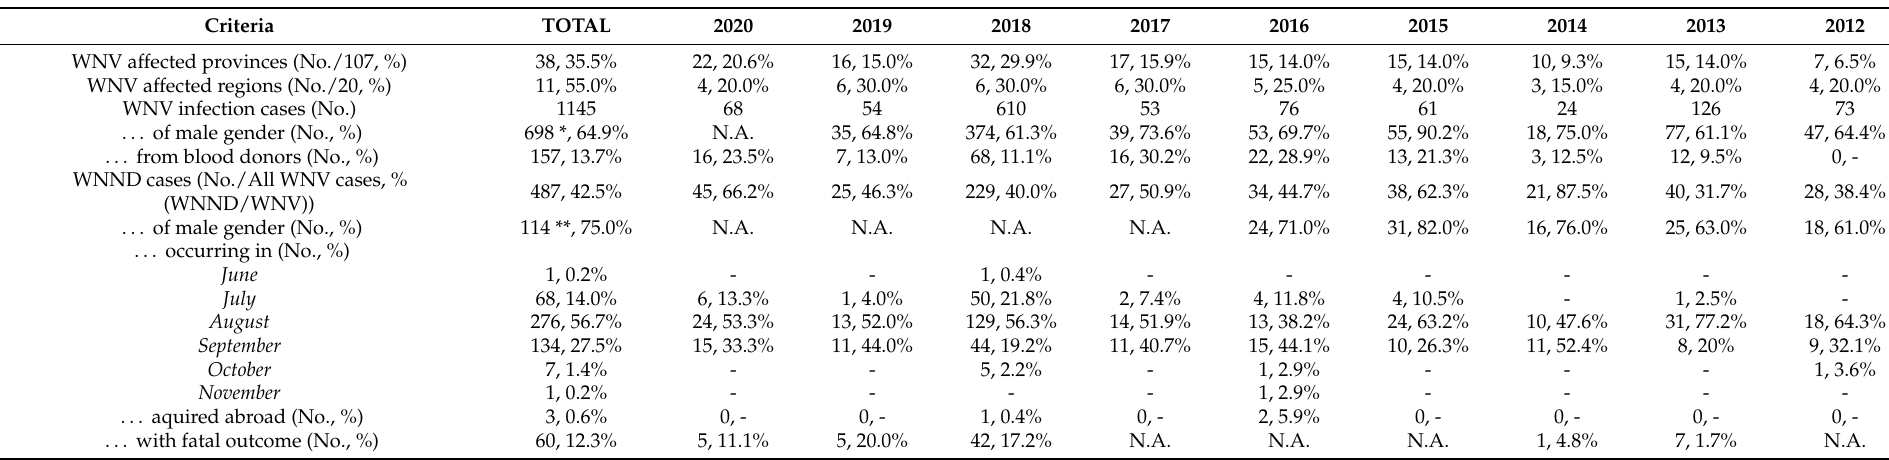
Table 1. Summary of collected data about West Nile virus (WNV) infections, with a specific focus on West Nile neuro-invasive disease (WNND) cases and related deaths in Italy, 2012–2020 (NA = not